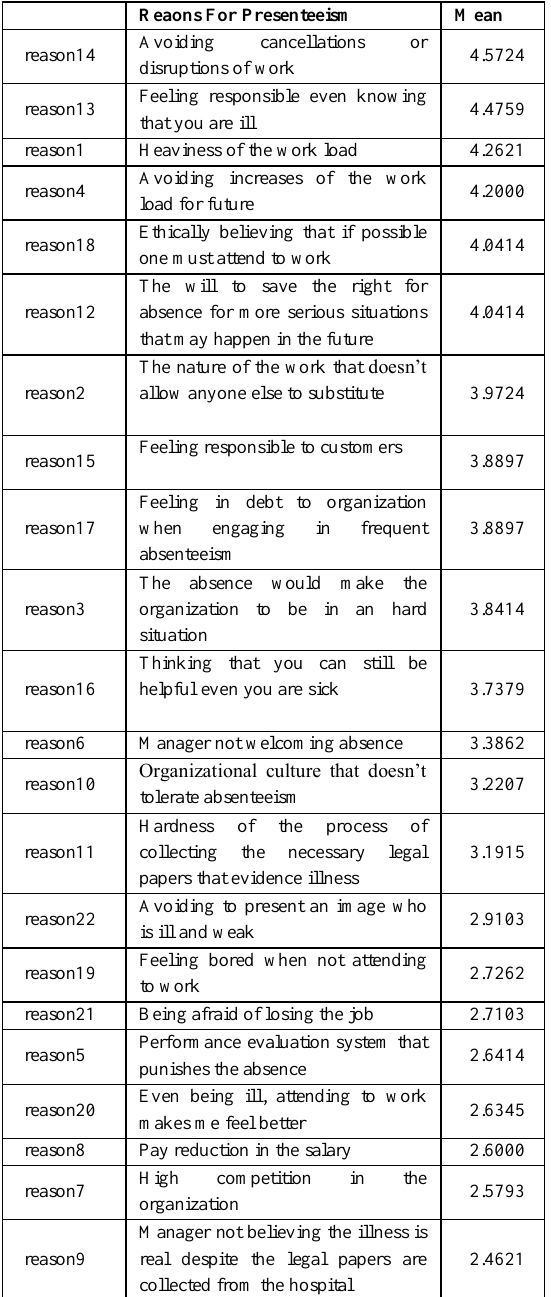
Table 7: Reasons for Presenteeism and Their Means